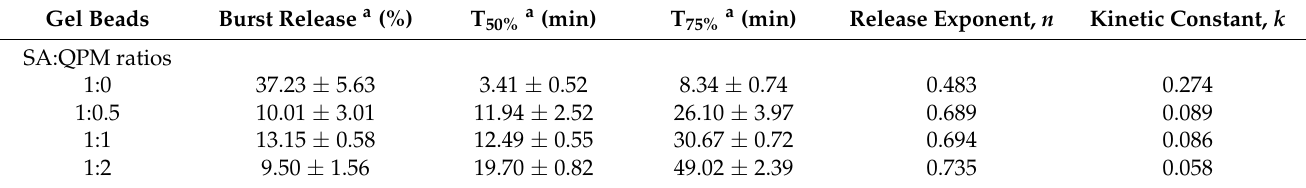
Figure 8. PPN release profiles of PPN-loaded CA-QPM gel beads at different SA:QPM ratios. Each value is the mean ± S.D., n = 3. Table 3. Drug release characteristics of PPN-loaded CA-QPM gel beads.